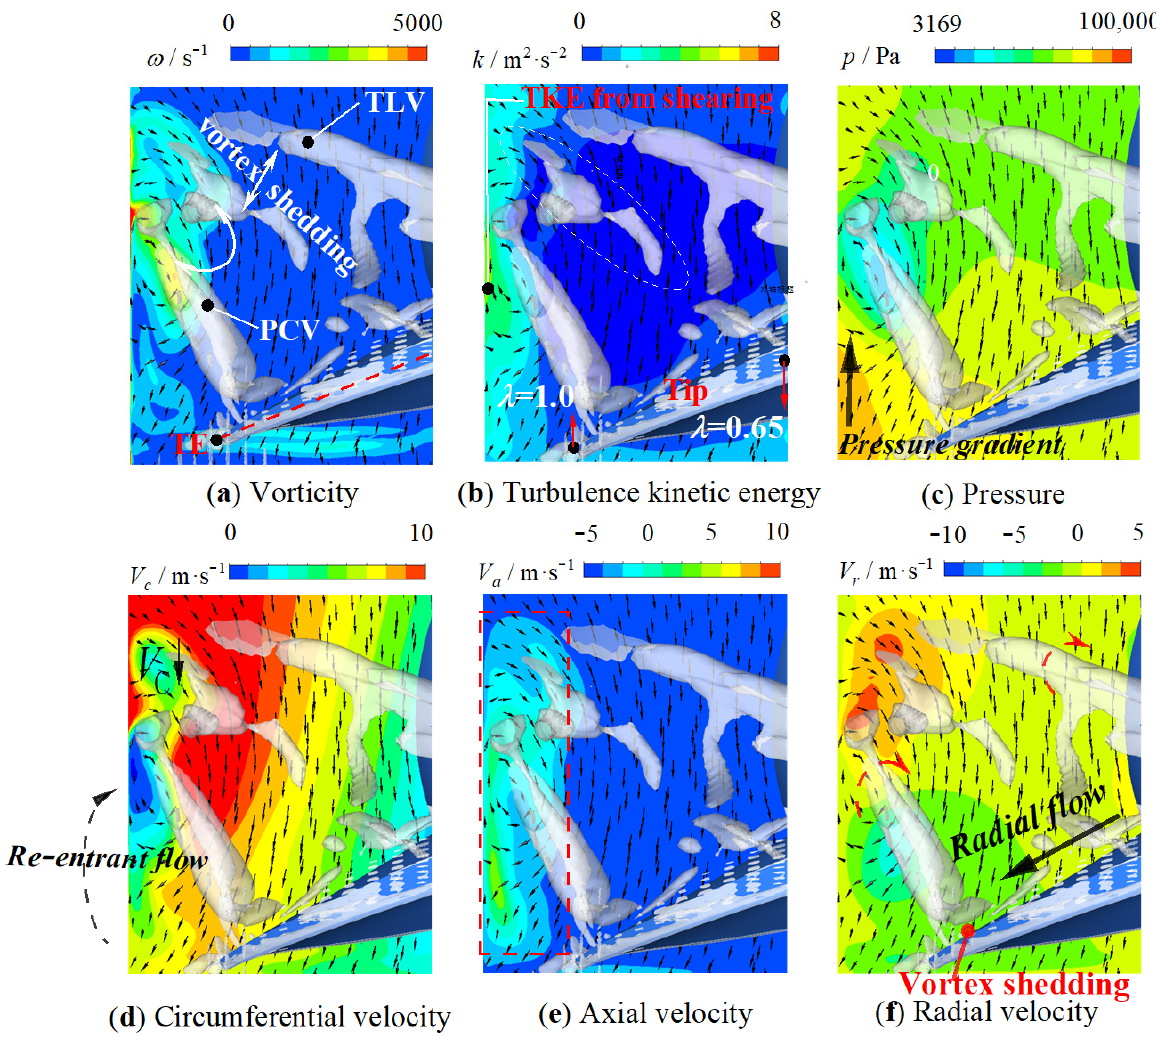
Figure 16. Distribution of plane physical quantities in the stage of vortex development and evolution at t = t 0 + 5T/30 ( swirling strength isosurface Sw = 1000 s − 1 (white) , Q = 0.8 Q BEP , σ = 0.35).